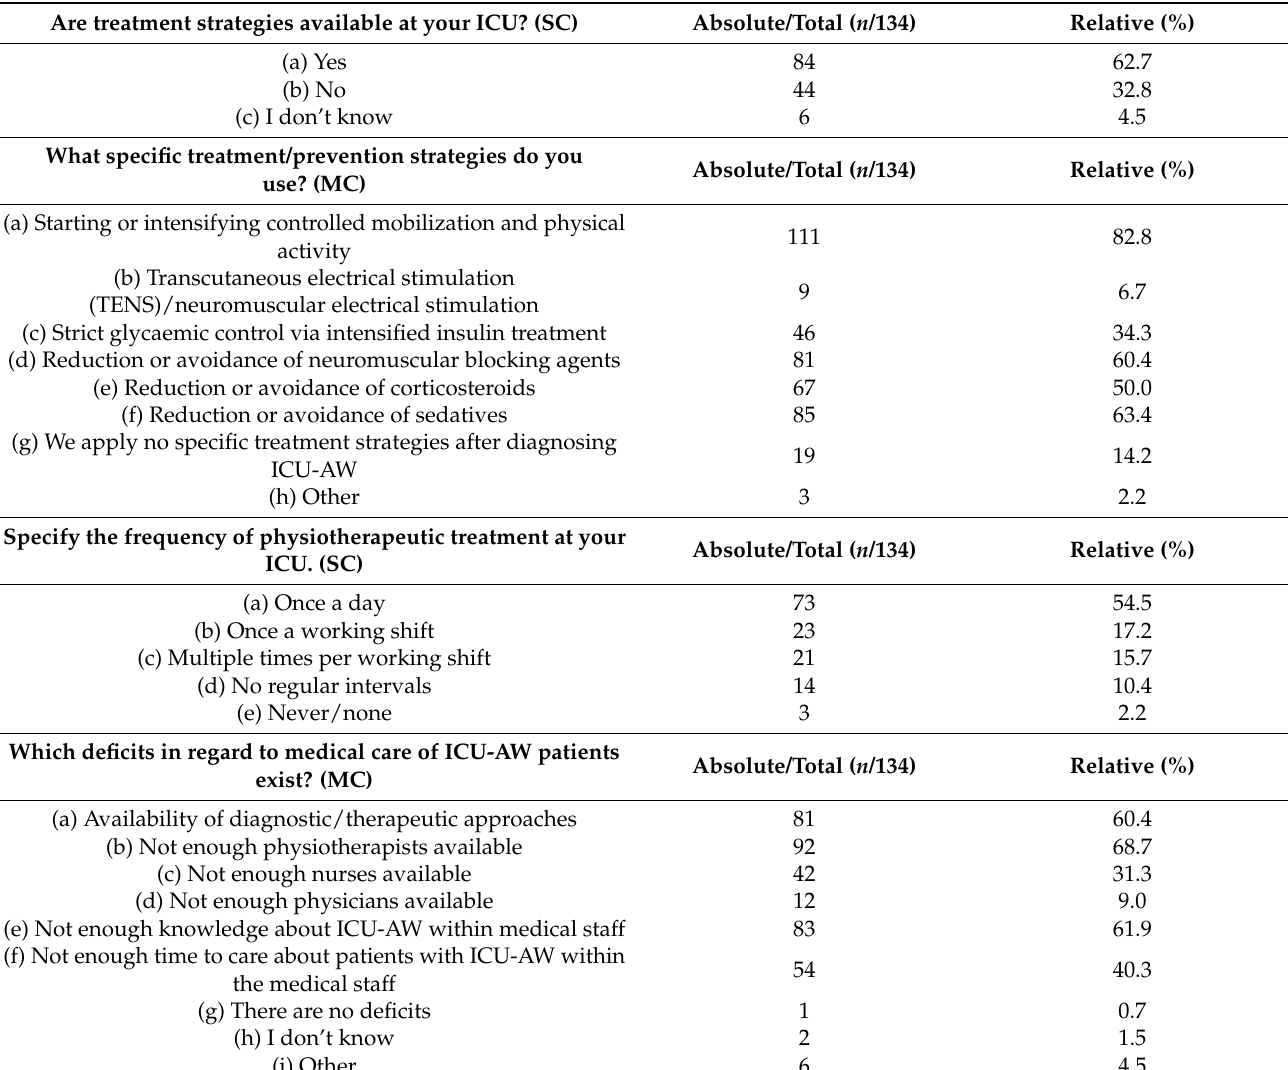
Table 3. Treatment and prevention strategies. Absolute counts indicate all participants who chose the particular answer of the corresponding question. Total counts indicate all study participants who answered the question at all. Relative counts indicate the ratio of absolute to total counts in